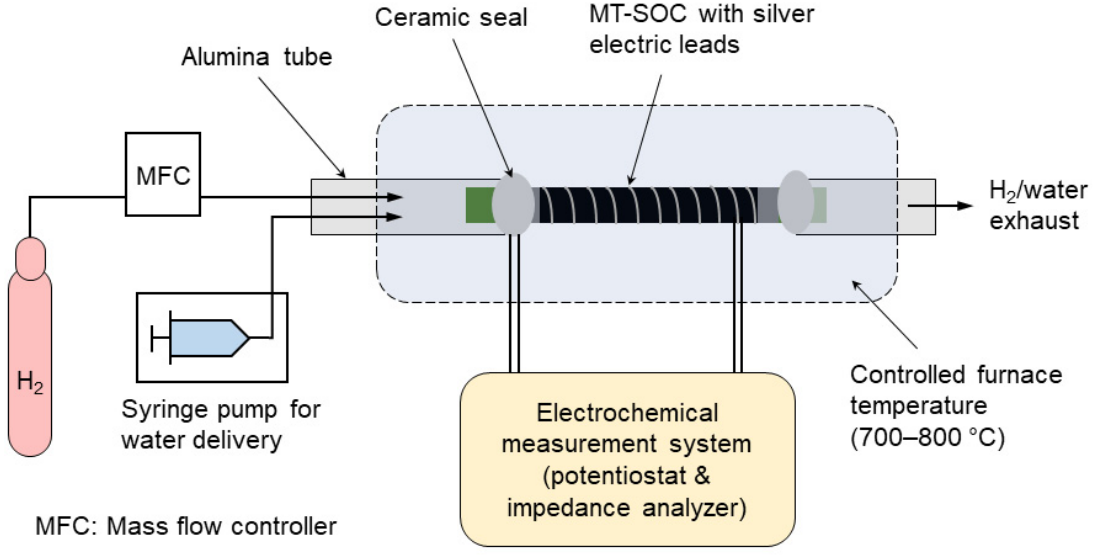
Figure 1. Schematics of the electrochemical testing setup.